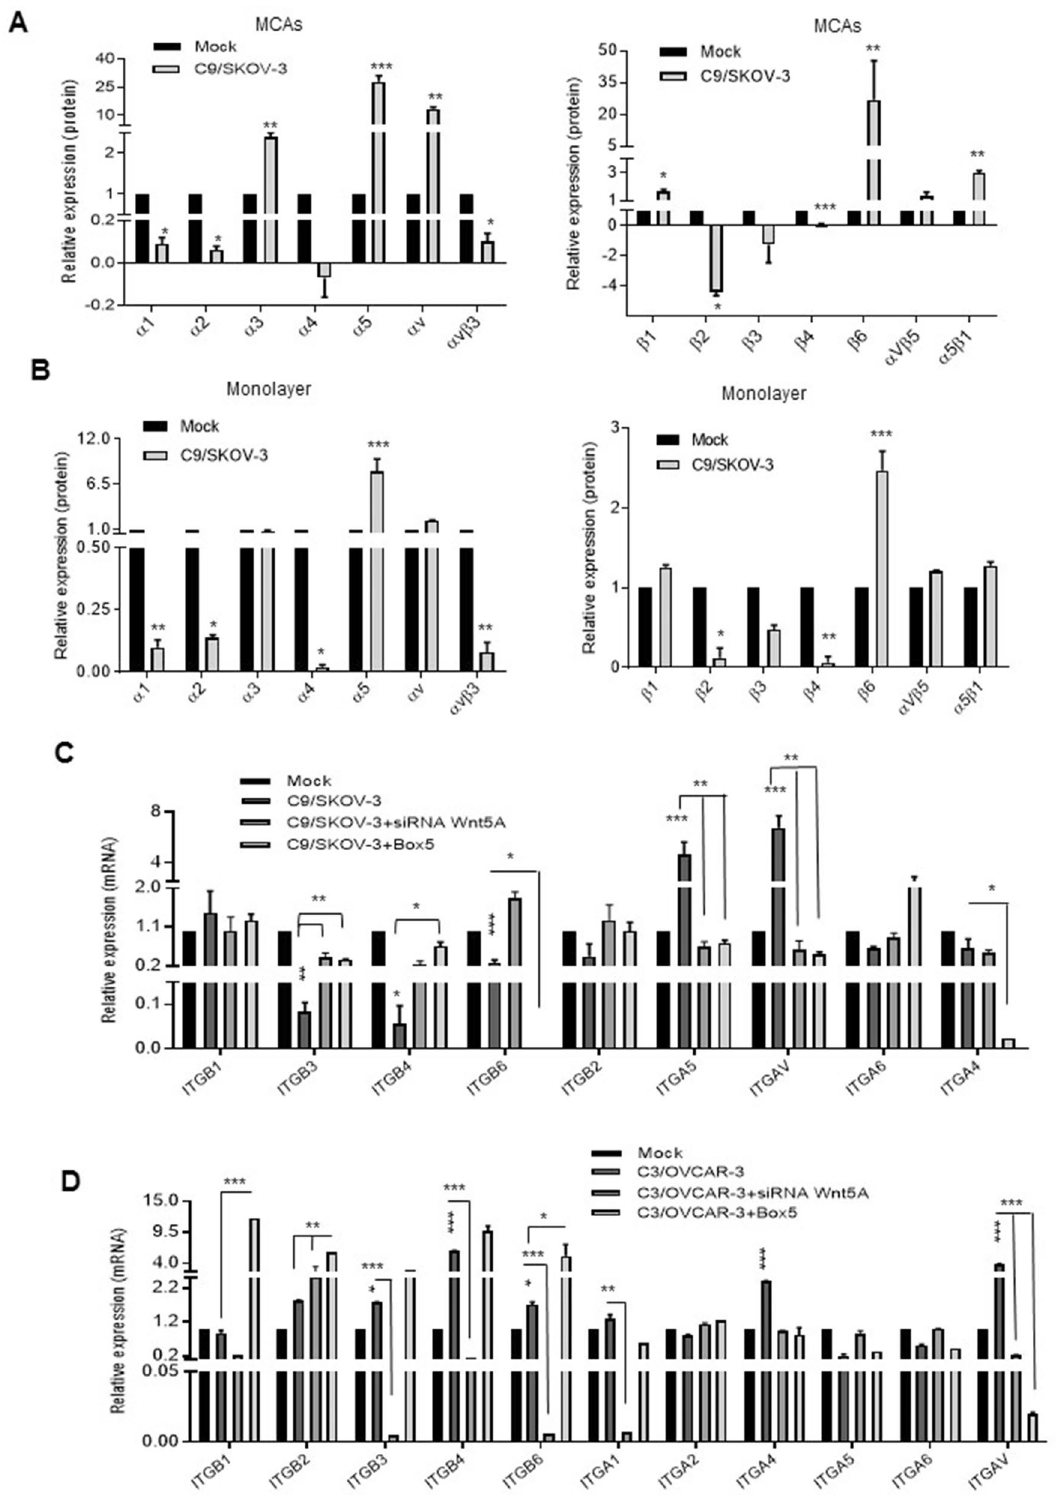
Figure 5. Wnt5A modulates integrin expression in Wnt5A overexpressing clones in both 2D and 3D cell culture. ( A ) The integrin expression level was assessed in 3D and ( B ) 2D Wnt5A overexpressing C9/SKOV-3 clone and mock cells by using the Alpha/Beta Integrin-Mediated Cell Adhesion Array Combo Kit. Values were normalized related to mock from two independent experiments each performed in duplicate (mean + SD). ( C ) RT-qPCR analysis of integrin subunits in C9/SKOV-3 clone with or without siRNA Wnt5A or Box5 relative to mock or scrambled (scr). ( D ) RT-qPCR analysis of integrin subunits in C3/OVCAR-3 clone with or without siRNA Wnt5A or Box5 relative to mock or scrambled (scr). GAPDH was used as an internal control and the data represent mean ± SD (n = 3) * P < .05; ** P < .01; *** P < .001 compared to